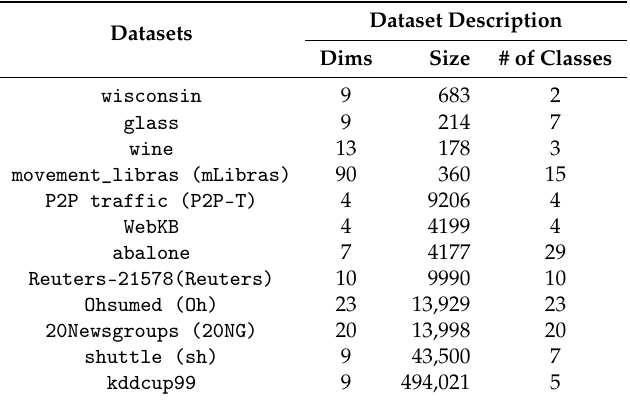
Table 2. Description of the benchmark